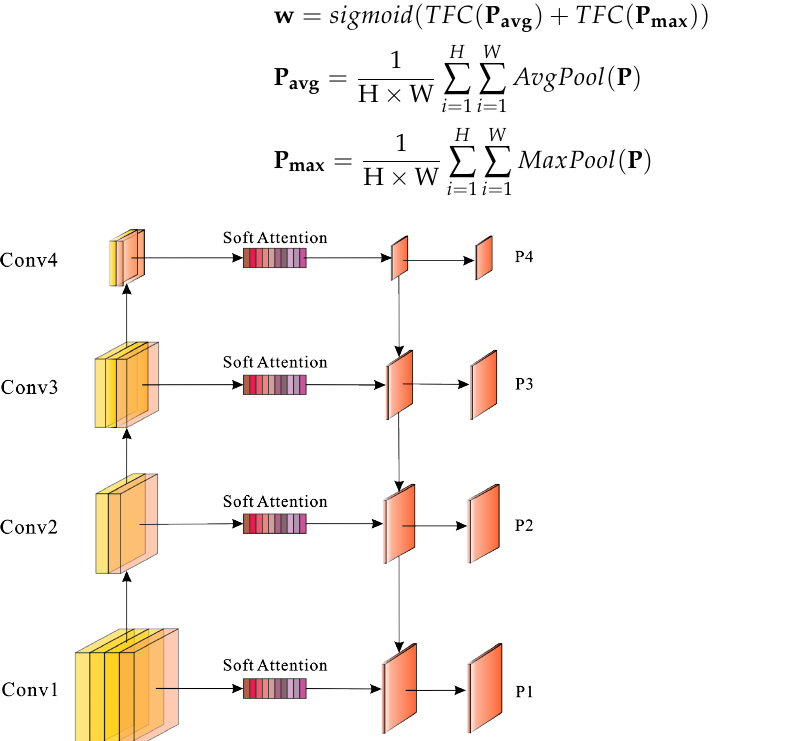
Figure 4. Introducing the soft attention mechanism to FPN. The feature weight vector was used in each the convolution layer, and obtained different levels of importance for different